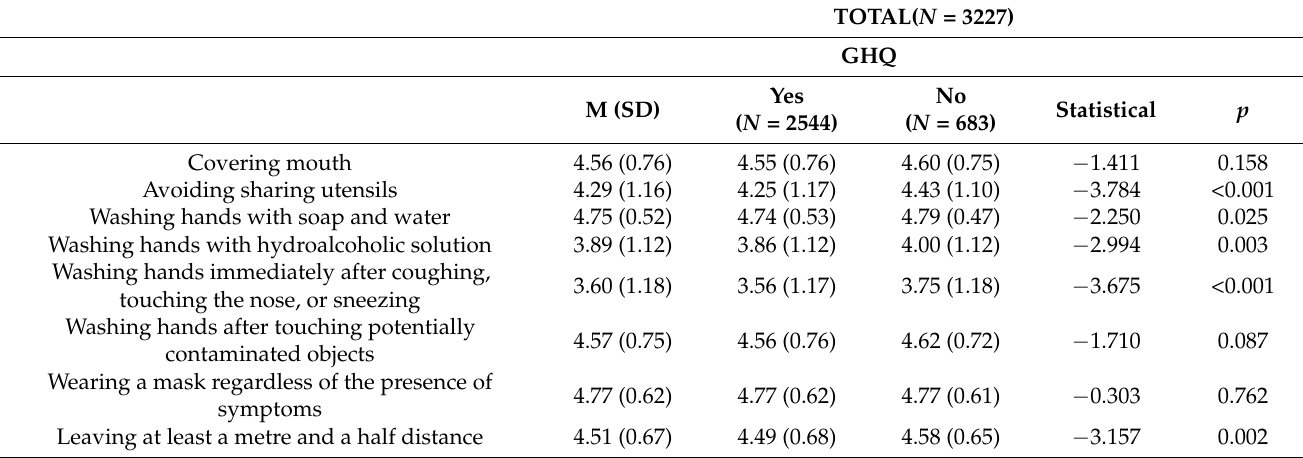
Table 5. Contrast between preventive measures and psychological distress during the